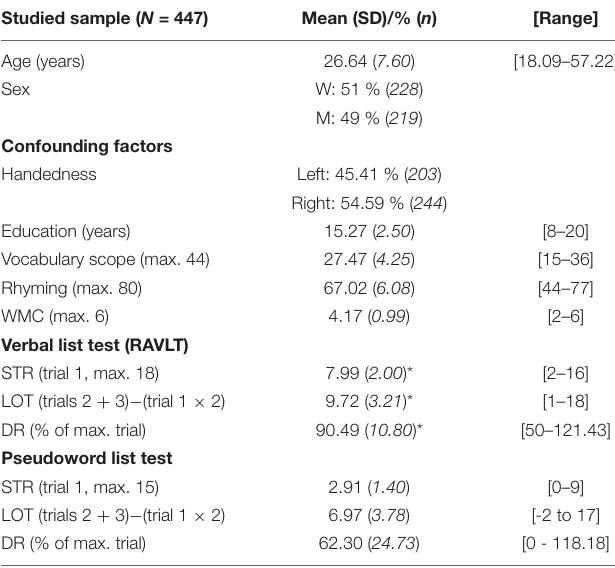
TABLE 2 | Descriptive data of the studied sample and memory